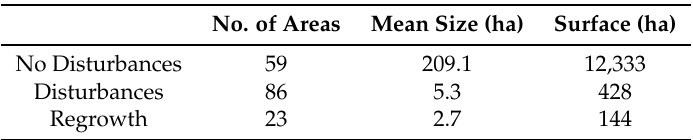
Table 1. Numbers and sizes of the reference polygons constituting the training and testing database for forest disturbances and regrowth